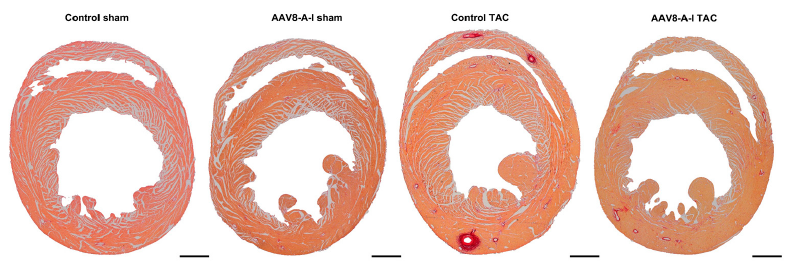
Figure 2. Representative Sirius red-stained cross-sections of sham hearts and transverse aortic constriction (TAC) hearts at day 56 after operation. Scale bar represents 1 mm.